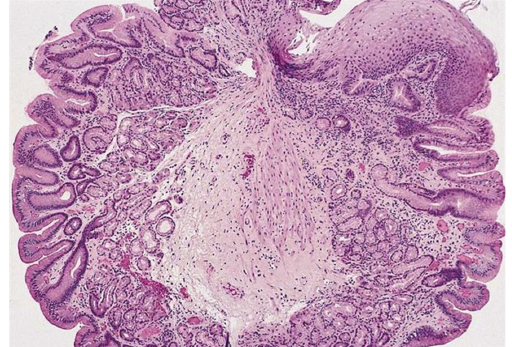
Figure 4: Histology of a portion of an inlet patch from a di ff erent patient showing gastric mucosa adjacent to normal esophageal mucosa with stratified squamous epithelium (top left). The gastric mucosa shown here is antral-type as there are no oxyntic (acid- secreting parietal cell)